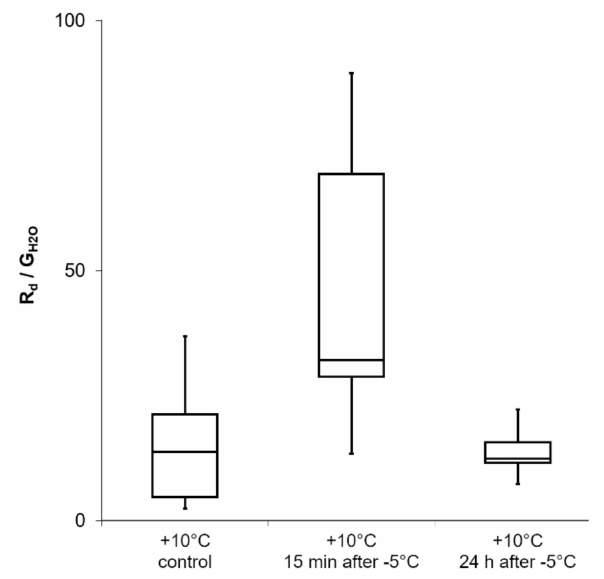
Figure 8. Gas exchange measurements during a freezing and thawing (recovery) experiment on R. glacialis leaves. The Boxplots show the dark respiration rate (R d ) in dependence on the di ff usive conductance rate (G H20 ). The mean value is increased but without statistical significance ( p > 0.05; repeated measures ANOVA with Bonferroni-correction). Boxes indicate the median (horizontal line inside the box) and the 25th and the 75th percentile (bottom and top border). Whiskers indicate maxima and minima and extend maximum to 1.5 times